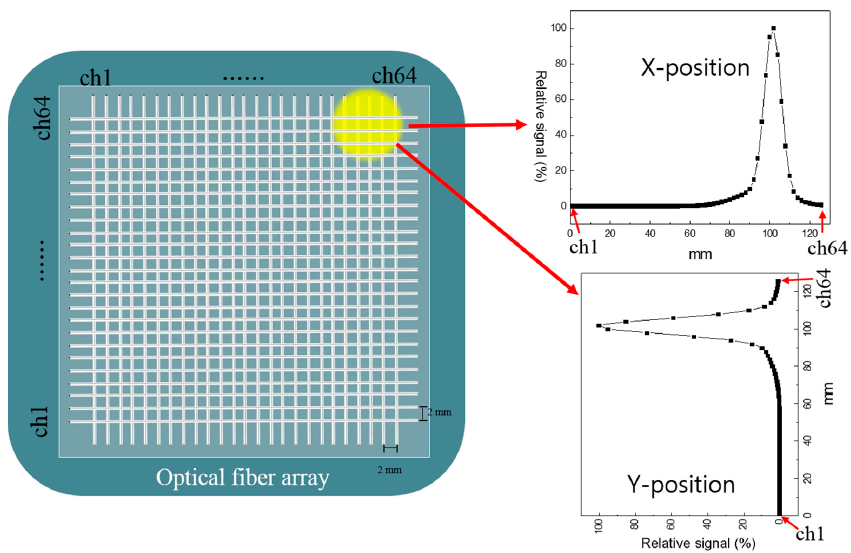
Figure 3. Schematic image of position localization using the FORS.